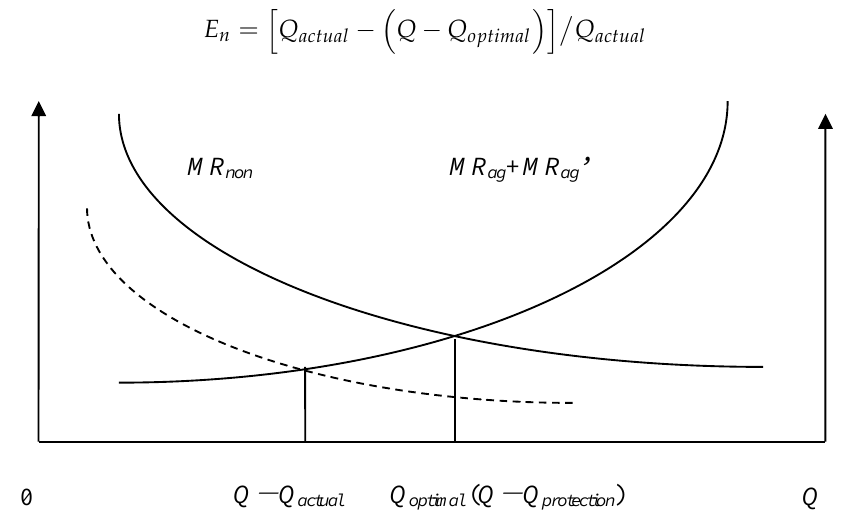
Figure 3. Allocation of county-level land resources under the third situation.